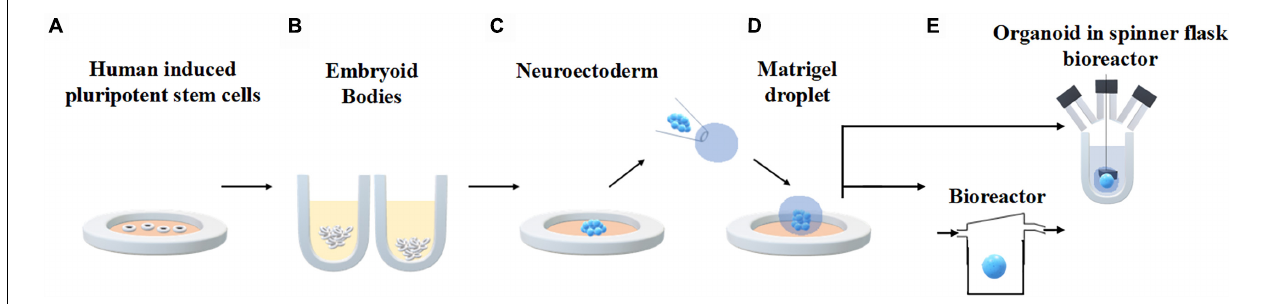
FIGURE 3 | Generation of human brain organoids. Human stem cells are seeded onto plates (A) in order to allow embryoid body formation (B) . Neuroectoderm is generated after neural induction (C) . The cells are embedded in Matrigel droplets (D) and transferred to a spinner flask or a fluidic bioreactor (E)